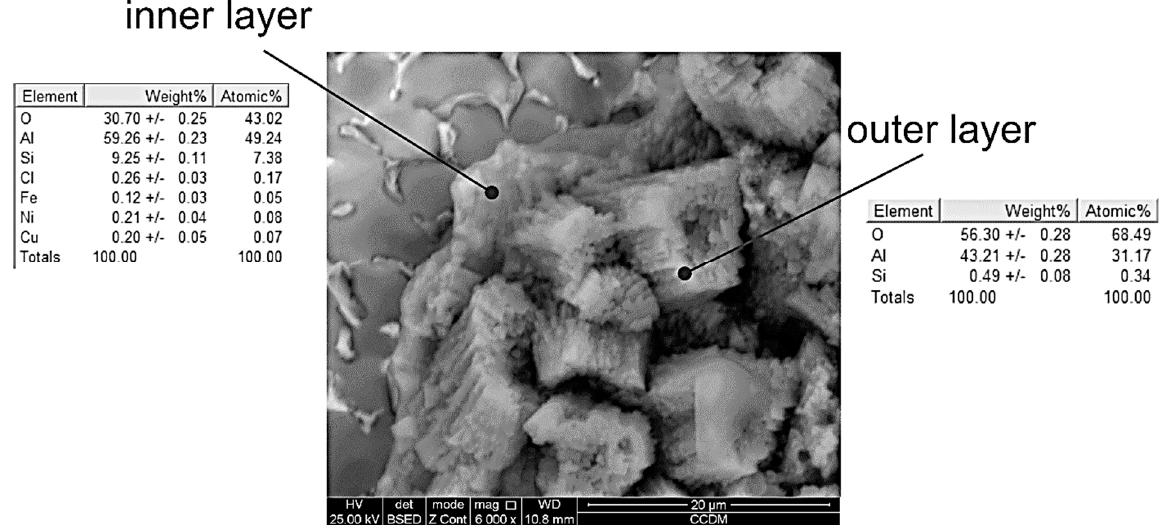
Figure 13. EDS measurements related to the inner and outer oxide layers formed during 30-day immersion experiments of the CC Al-7%Si-0.6%Fe-0.35%Cu-0.25%Zn-0.5%Ni